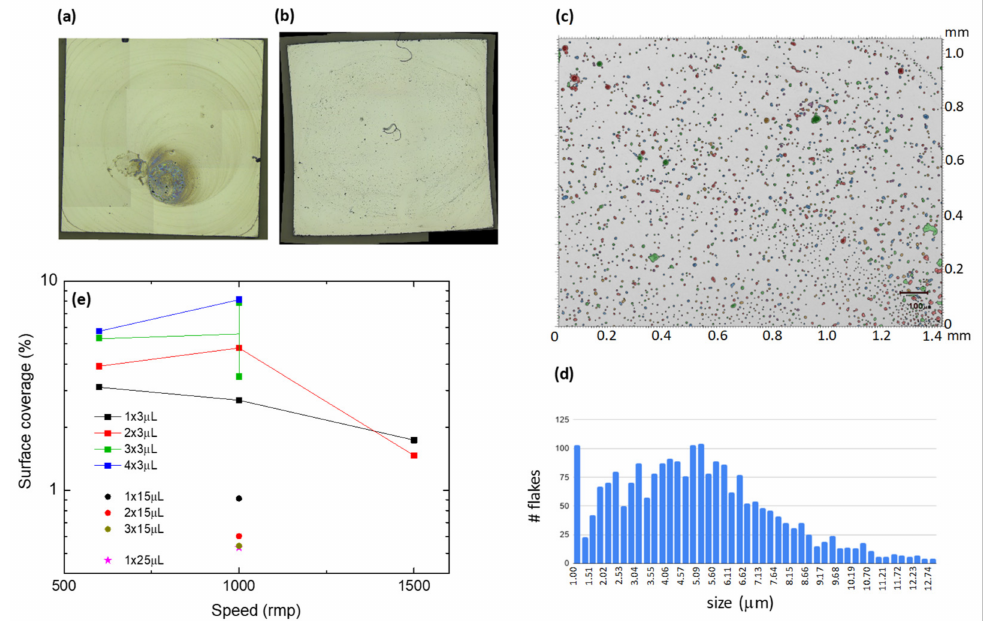
Figure 4. Optical image of 5 × 5 mm 2 silicon wafer with deposited Tb-MOF flakes, by drop-casting ( a ) and spin-coating ( b ); ( c ) quantification of surface coverage and ( d ) distribution of flake sizes, for a spin-coated sample; ( e ) surface coverage determined for different spin-coating conditions.